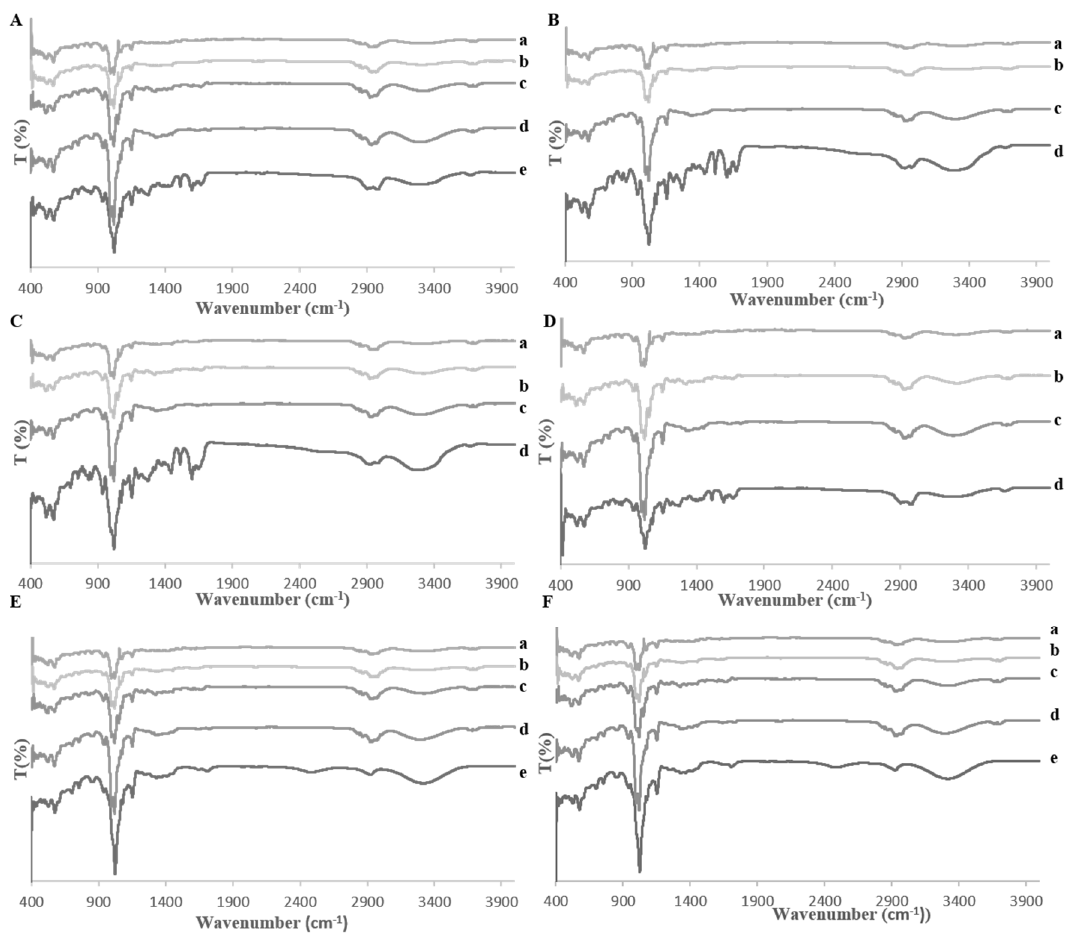
Figure 3. Fourier-transform infrared spectroscopy graphs: ( A ) (a) trans-ferulic acid, (b) ca ff eic Figure 3. Fourier ‐ transform infrared spectroscopy graphs: ( A ) (a) trans ‐ ferulic acid, (b) caffeic acid, acid, (c) p -coumaric acid, (d) β -cyclodextrin, (e) mixture, ( B ) (a) trans-ferulic acid, (b) ca ff eic acid, (c) p ‐ coumaric acid, (d) β ‐ cyclodextrin, (e) mixture, ( B ) (a) trans ‐ ferulic acid, (b) caffeic acid, (c) β ‐ (c) β -cyclodextrin, (d) mixture, ( C ) (a) ca ff eic acid, (b) p -coumaric acid, (c) β -cyclodextrin, (d) mixture, cyclodextrin, (d) mixture, ( C ) (a) caffeic acid, (b) p ‐ coumaric acid, (c) β ‐ cyclodextrin, (d) mixture, ( D ) ( D ) (a) trans-ferulic acid, (b) p -coumaric acid, (c) β -cyclodextrin, (d) mixture; ( E ) (a) trans-ferulic acid, (a) trans ‐ ferulic acid, (b) p ‐ coumaric acid, (c) β ‐ cyclodextrin, (d) mixture; ( E ) (a) trans ‐ ferulic acid, (b) (b) ca ff eic acid, (c) p -coumaric acid, (d) β -cyclodextrin, (e) mixture; ( F ) (a) trans-ferulic acid, (b) ca ff eic caffeic acid, (c) p ‐ coumaric acid, (d) β ‐ cyclodextrin, (e) mixture; ( F ) (a) trans ‐ ferulic acid, (b) caffeic acid, (c) p -coumaric acid, (d) β -cyclodextrin, and (e) extract and β -cyclodextrin acid, (c) p ‐ coumaric acid, (d) β ‐ cyclodextrin, and (e) extract and β ‐ cyclodextrin mixture.